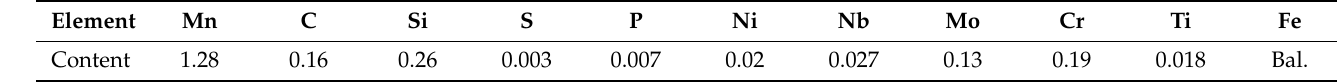
Table 1. The chemical composition of high-strength steel (wt%) [19].